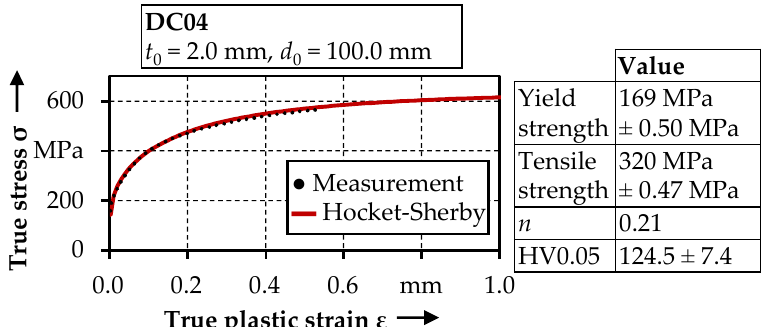
Figure 4. Material characterization of DC04 [4].